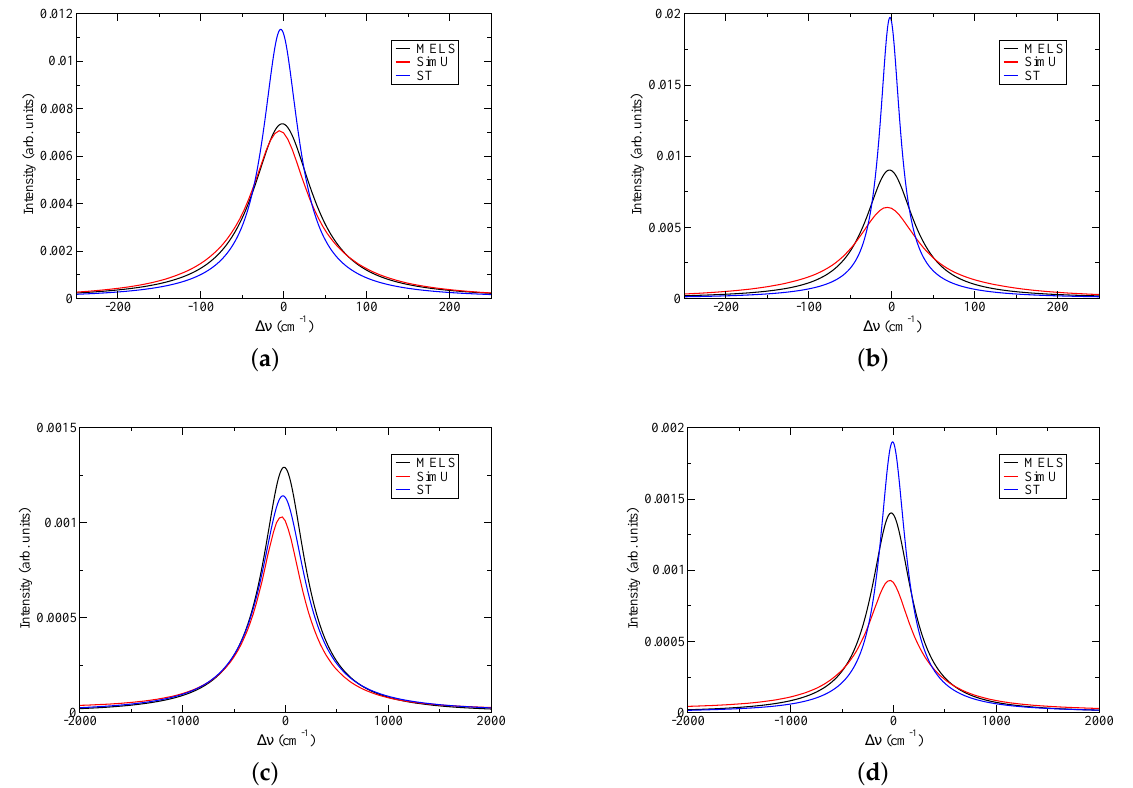
Figure 6. Sub-cases with quenching. Plasma conditions assumed are as follows: ( a ) n e = 10 18 cm − 3 and T = 4eV; ( b ) n e = 10 18 cm − 3 and T = 10eV; ( c ) n e = 10 19 cm − 3 and T = 4eV; ( d ) n e = 10 19 cm − 3 and T =